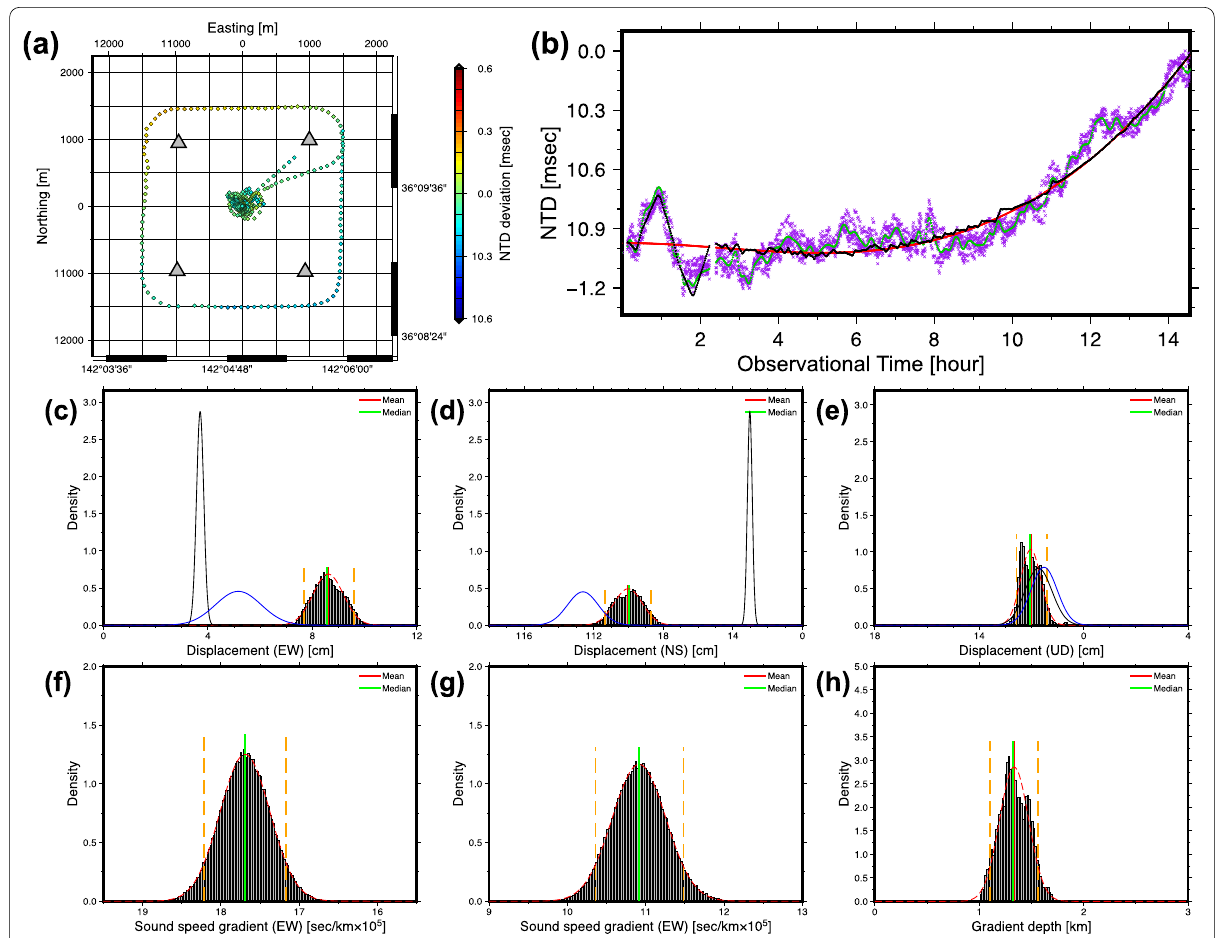
Fig. 7 Estimation results of Method-3 at G20 on November 13, 2015. Each panel is described in the same manner as in Fig.